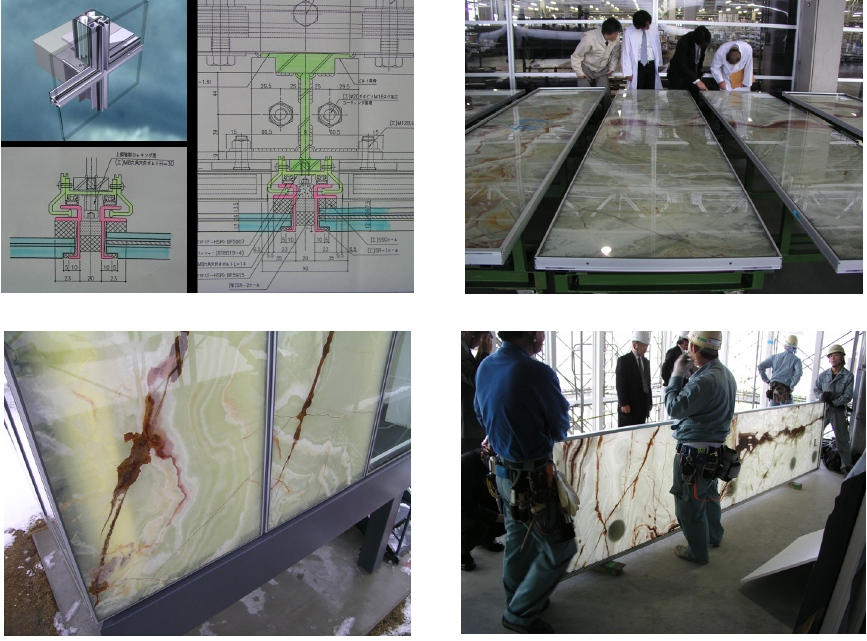
Figure 4a, b, c, d: System Details, Production Panels, Visual Mock-Up, Panel